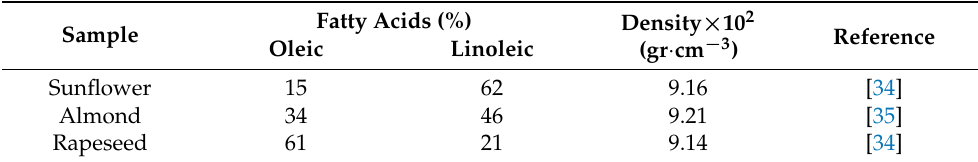
Table 3. Fatty acids content and density for the studied